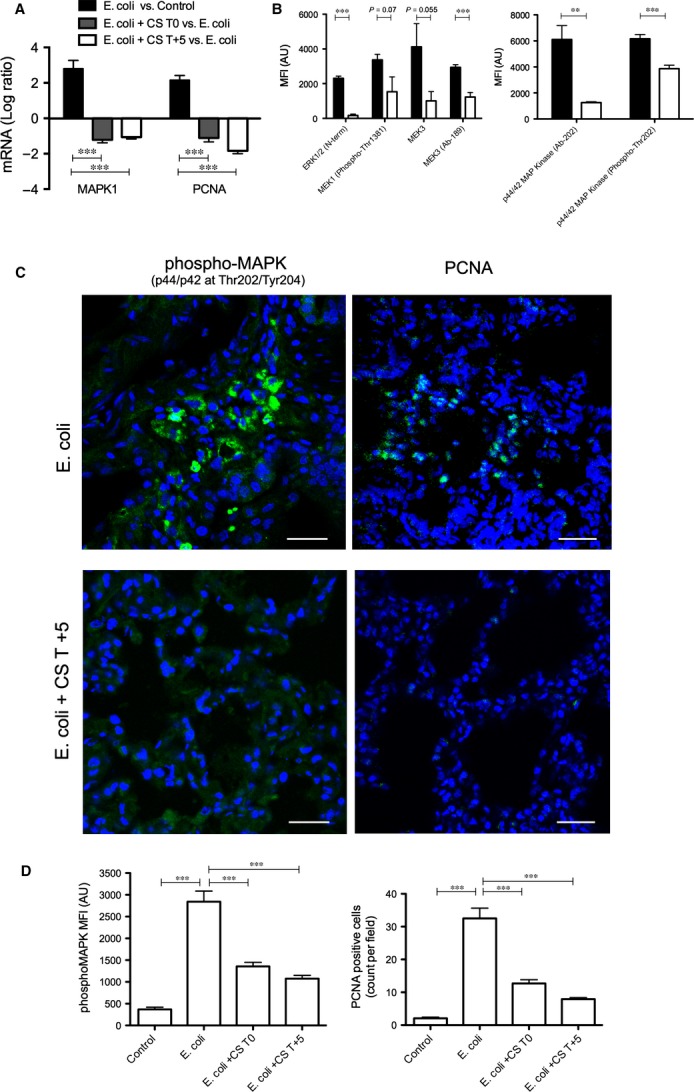
Compstatin inhibits sepsis-induced myofibroblast proliferation. (A) Log ratio of qPCR data showing transcript levels for proliferation signalling (MAPK1) and marker (PCNA) proteins in Escherichia coli + CS T+5 versus E. coli animal groups. Expression values were normalized by housekeeping gene β-actin. Data are shown as mean ± S.E.M. of three replicates. One-way anova with Dunnett's multicomparison test; ***P < 0.001 as compared to E. coli versus Control ratio. (B) Phospho-antibody array analysis showing expression and phosphorylation of molecules involved in ERK and MEK proliferation signalling. Mean fluorescence intensity (MFI) data for antibody spots are presented as mean ± S.E.M. of six replicates per experimental condition with unpaired two-tailed t-test. **P < 0.01; ***P < 0.001. (C) Immunofluorescence staining for phospho-MAPK1 and PCNA in foci in the lungs of septic baboons, but not in compstatin-treated animals. Magnification: bar, 50 μm. (D) Histogram representation of MFI of images collected for the above-mentioned proteins. Data are shown as means ± S.E.M.; one-way anova with Dunnett's multicomparison test. ***P < 0.001 as compared to the E. coli group.